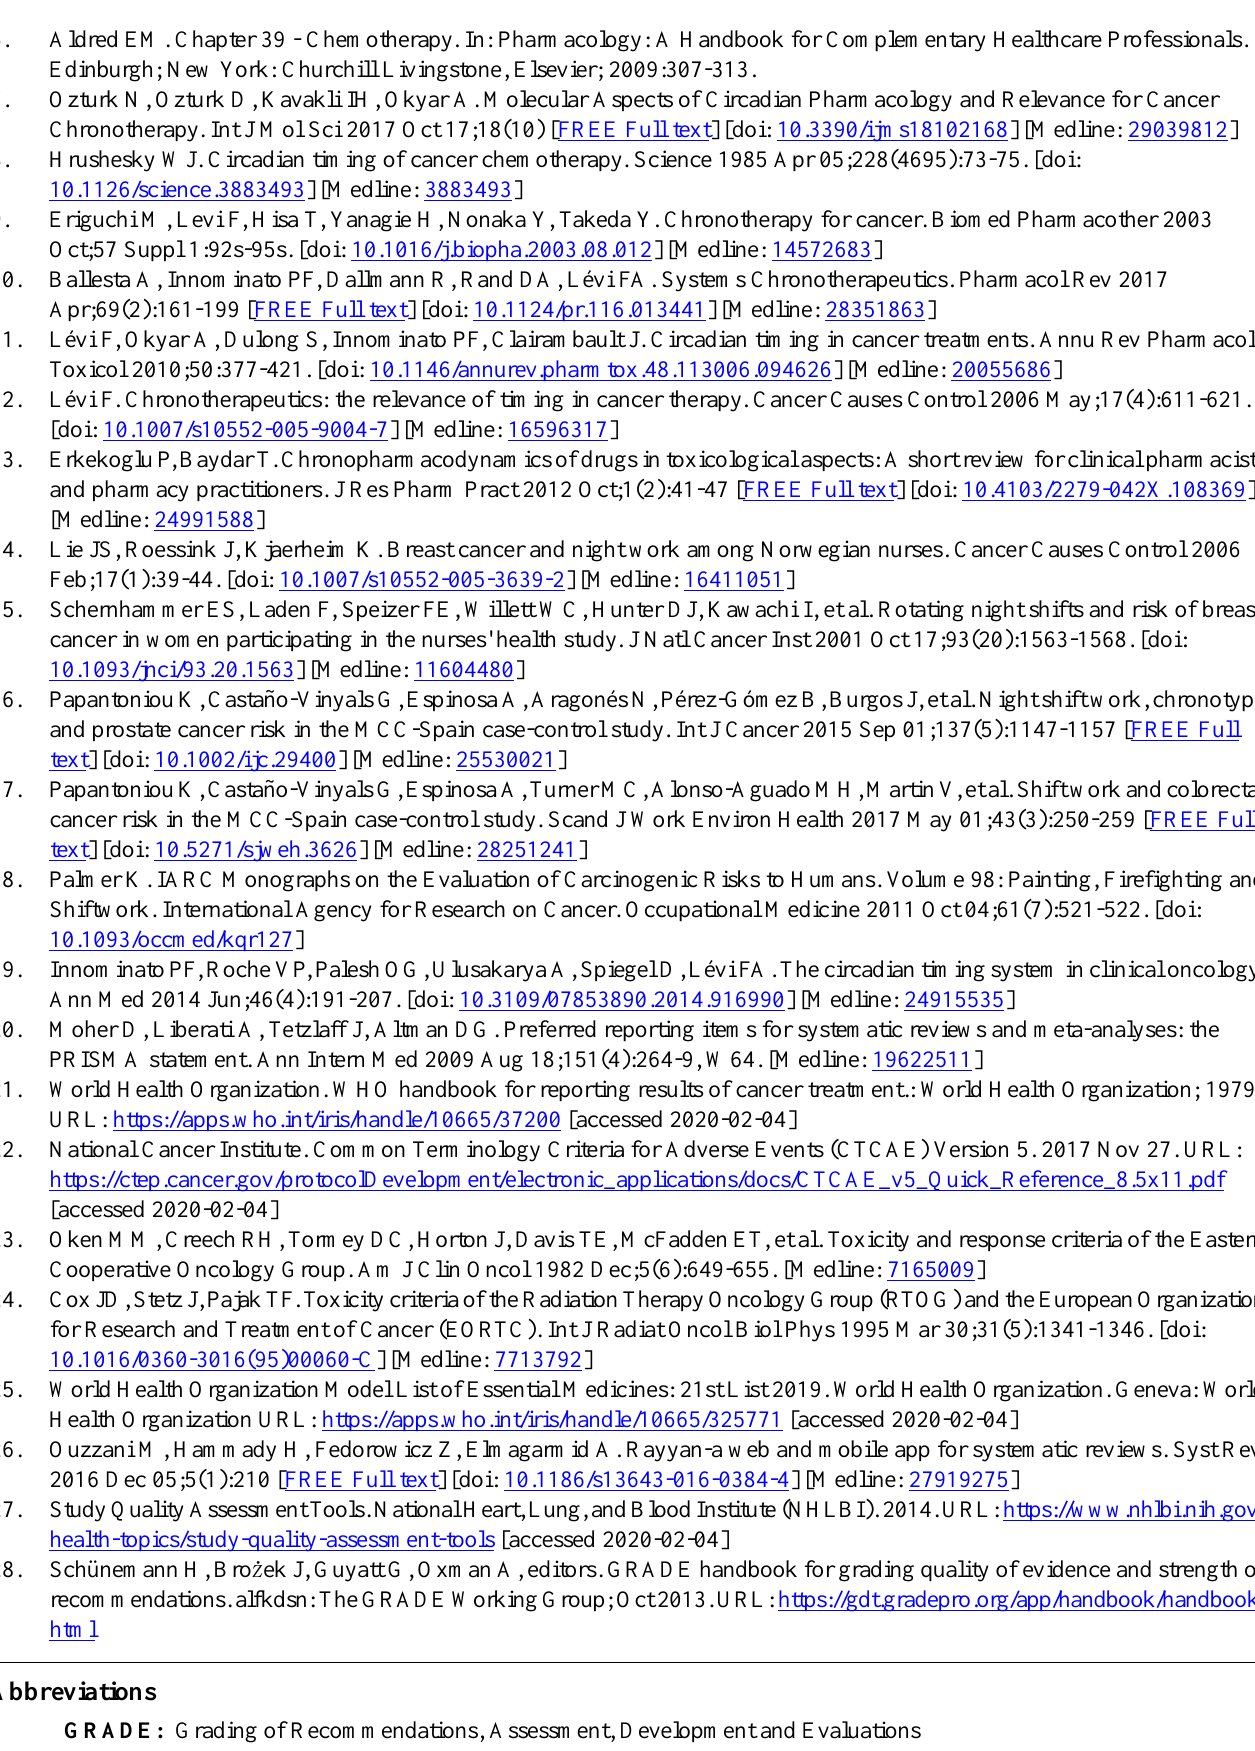
html Abbreviations GRADE: Grading of Recommendations, Assessment, Development and Evaluations MeSH: Medical Subject